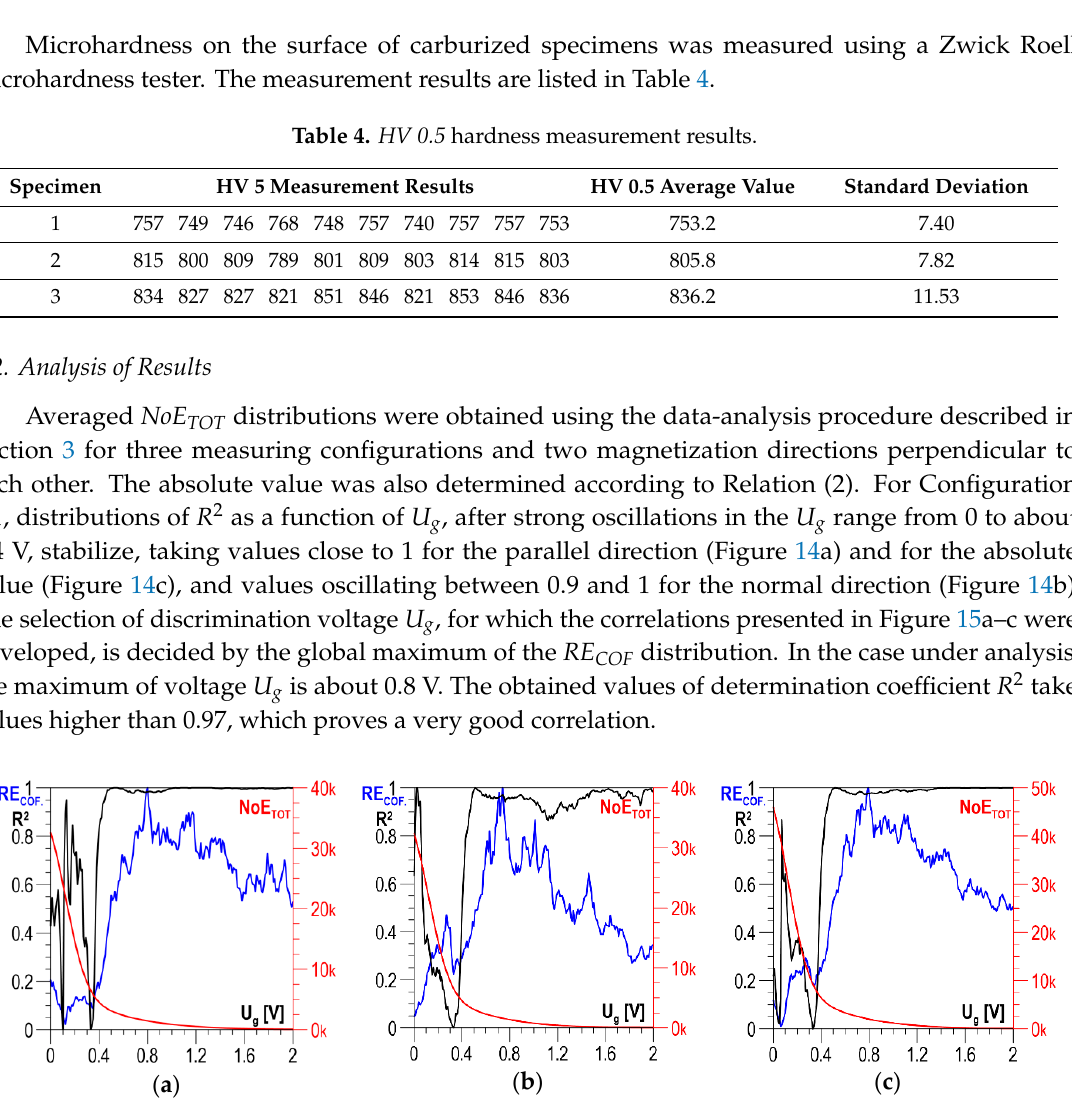
( c ) Figure 15. Linear correlations between NoE TOT and HV5 hardness—Configuration C1 ( a ) parallel direction, U g = 0.8 V; ( b ) normal direction, U g = 0.74 V; ( c ) absolute value, U g = 0.79 V.